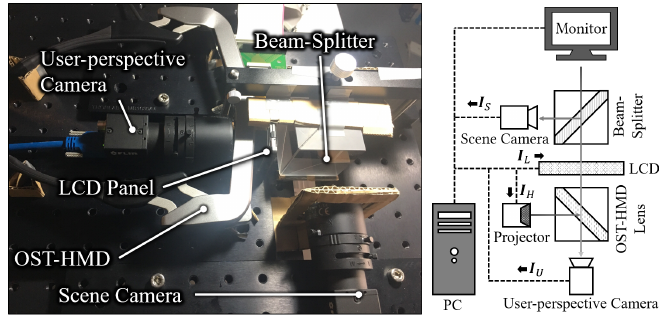
Figure 3. Hardware confiuration of the proposed prototype